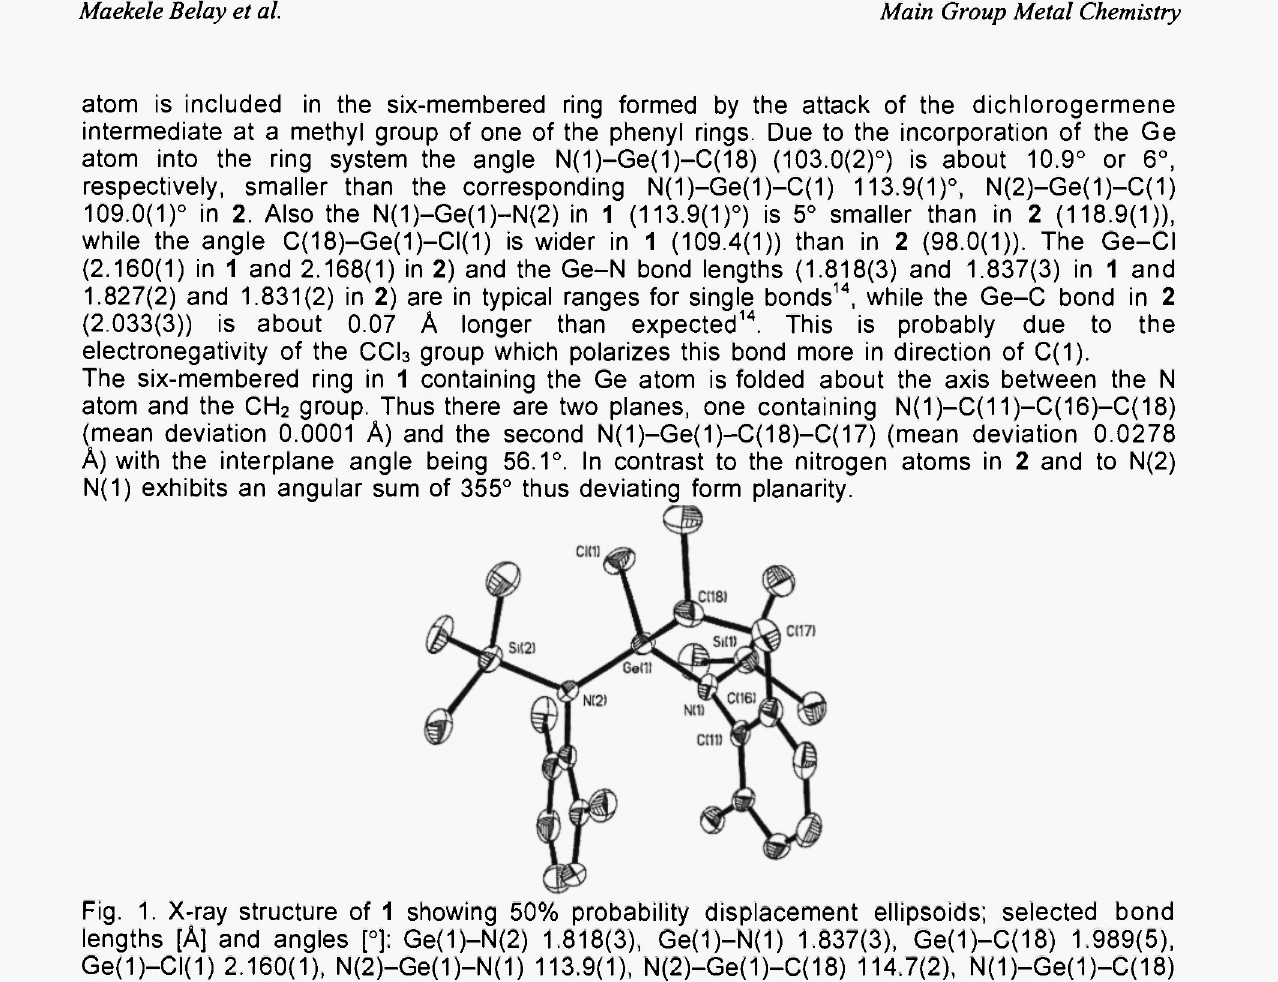
Fig. 1. X-ray structure of 1 showing 50% probability displacement ellipsoids; selected bond lengths [ A] and angles [°]: Ge(1)-N(2) 1.818(3), Ge(1)-N(1) 1.837(3), Ge(1)-C(18) 1.989(5),